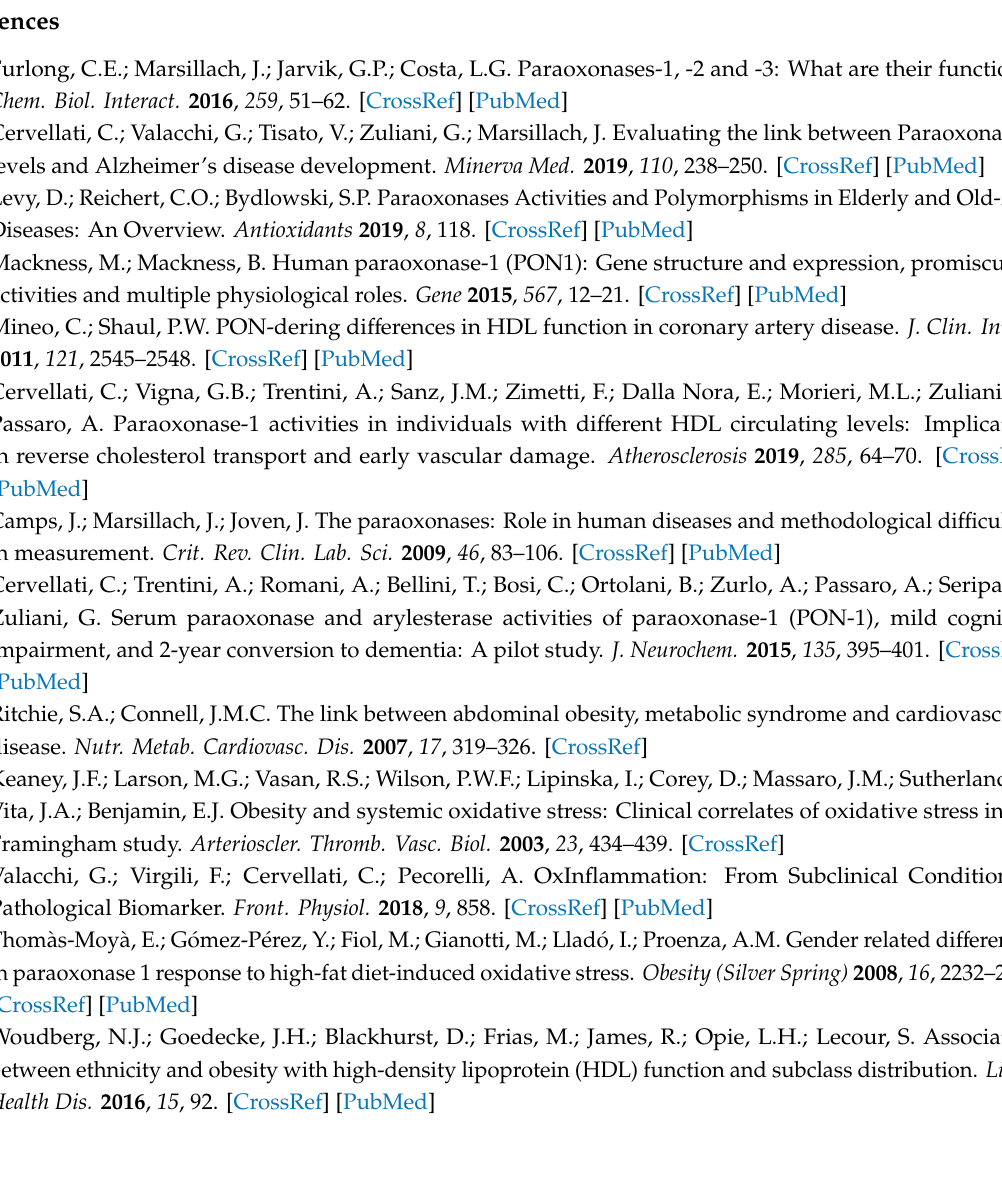
Table S1: Serum levels of adipokines and PON1 activities, Figure S1: Inverse correlation between resistin and lactonase